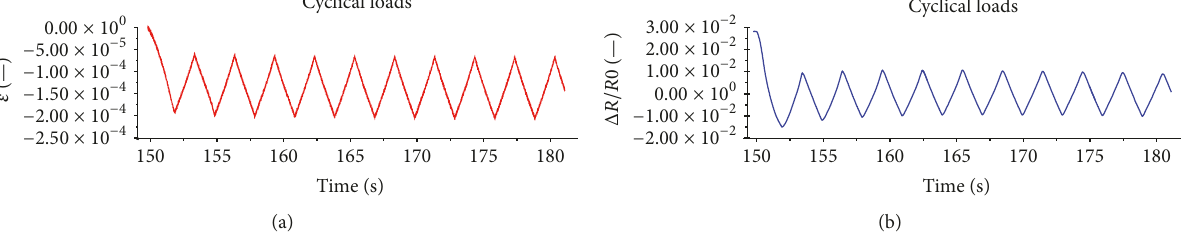
Figure 7: Results of electromechanical tests: measured average strain (a) and normalized variation of electrical resistance (b) on sample number 6 (typical) using the four-probe method under cyclical loads.